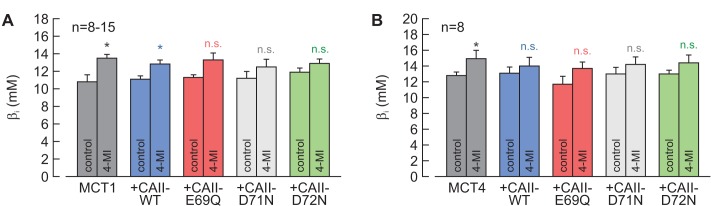
Intrinsic buffer capacity of oocytes.(A, B) Intrinsic buffer capacity (βi), as measured by the application of 5% CO2 and 10 mM HCO3–, in oocytes expressing MCT1 (A) or MCT4 (B), either alone or together with CAII-WT, CAII-E69Q, CAII-D71N, and CAII-D72N, in the absence or presence of 4-MI in the cytosol (mean + SEM). *p≤0.05, n.s. no significance; Student’s t-test.